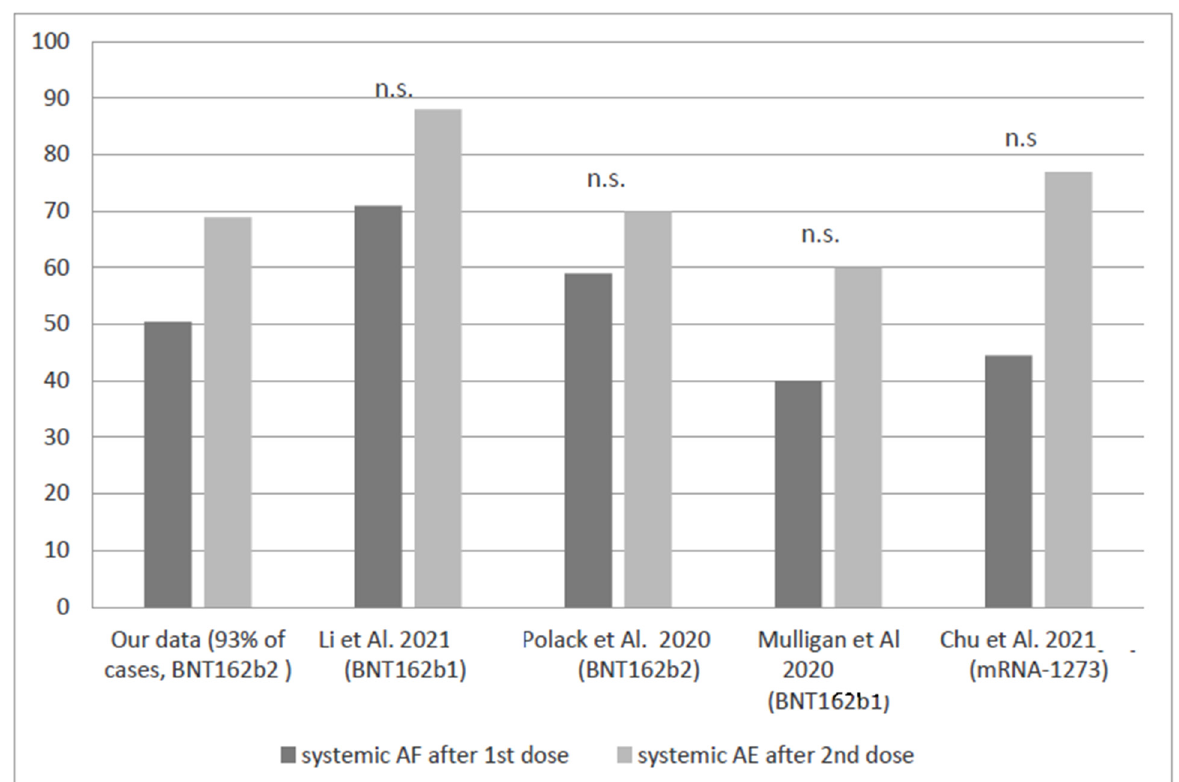
Figure 2. Prevalence of systemic AEs in our cohort and general population as reported by several studies: no significant differences were found between our data and data from other studies for both doses [22–25].